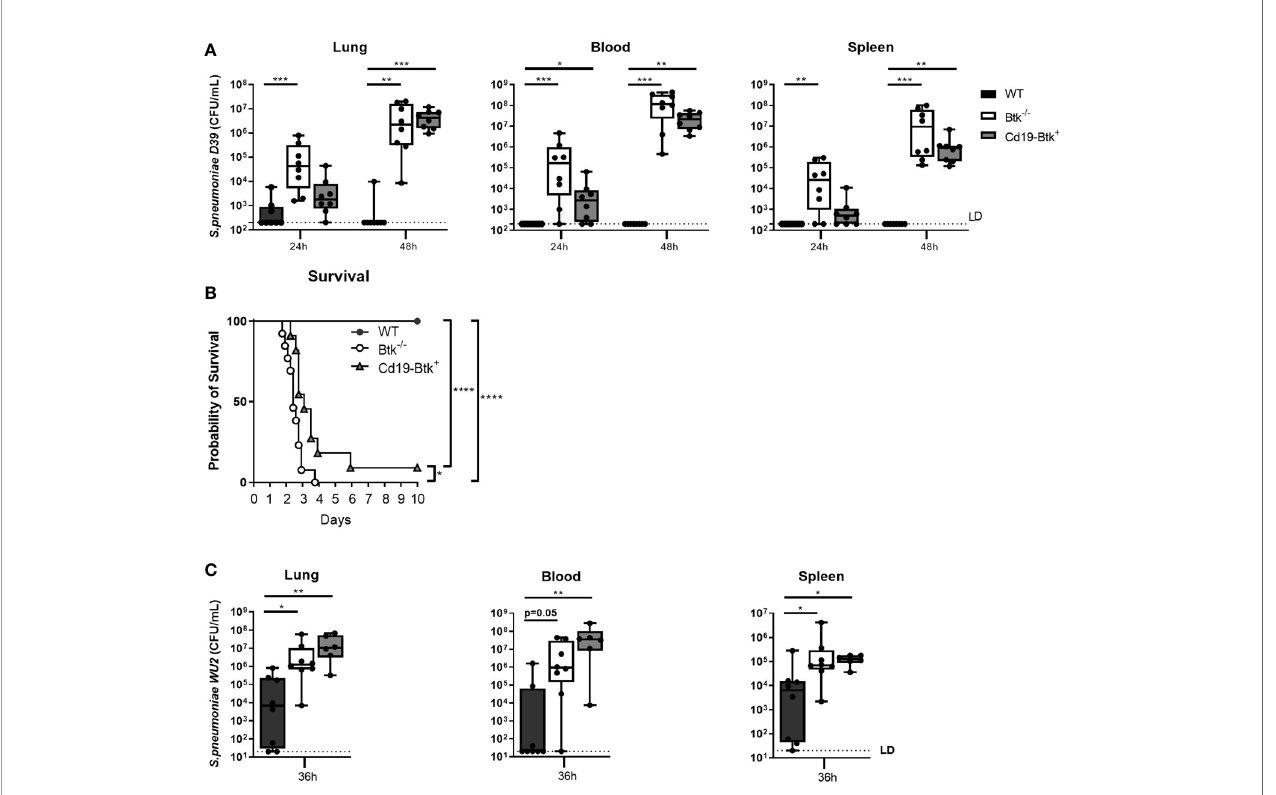
FIGURE 1 | Anti-pneumococcal natural antibodies improve host defense against D39 and WU2 during pneumosepsis to a limited extent. (A) WT, Btk -/- and Cd19- Btk + mice were intranasally inoculated with 2x10 6 CFU D39 (n=8 per group) and sacri fi ced 24 or 48 hours later. Bacterial counts in lung, blood and spleen are displayed. (B) Kaplan-Meier curve of the survival of WT (n=13), Btk -/- (n=13) or Cd19-Btk + (n=11) mice after intranasal inoculation with D39. (C) WT, Btk -/- and Cd19-Btk + mice were intranasally inoculated with 4000 CFU WU2 (n=6-8 per group) and sacri fi ced 36 hours later. Bacterial counts (CFU/mL) in lung, blood and spleen are displayed. For (A, B) data are expressed as box- and whisker plots showing the smallest value, lower quartile, median, upper quartile and largest value. LD= limit of detection. *p < 0.05, **p < 0.01, ***p < 0.001, ****p < 0.0001, Kruskall-Wallis test with false discovery rate correction (A, C) and log-rank test (B)